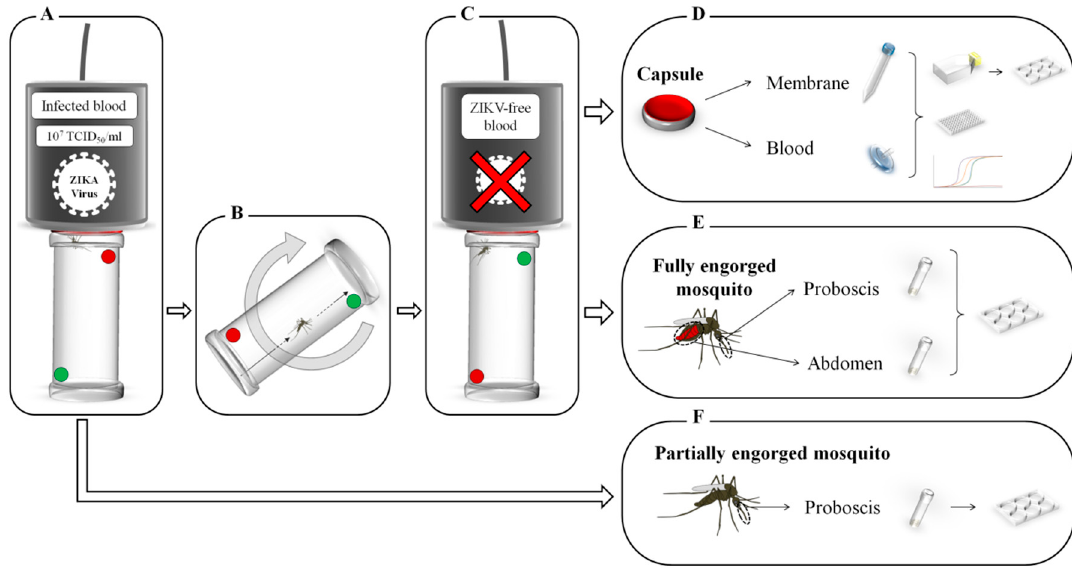
Figure 1. Experimental design used for the assessment of Zika virus (ZIKV) mechanical transmission by Aedes aegypti . ( A ) Mosquitoes were individualized in plastic tubes and allowed to start feeding on ZIKV-infected blood meal (called source capsule ) until blood was visually detected in their abdomen. ( B ) Once blood was detected, the tube was turned upside down and transferred to a virus-free blood meal (called receiver capsule ). ( C ) The mosquito was allowed to complete the blood meal for 30 min. ( D ) After engorgement, the receiver capsule compartments (feeding membrane and blood; N = 22) were screened for ZIKV by titration (virus culture, TCID 50 and plaque assays) and by real time RT-qPCR. ( E,F ) Fully engorged mosquito compartments (abdomens and proboscises; N = 22) as well as proboscises of partially engorged mosquitoes (only fed on the source capsule; N = 25) were investigated for the presence of ZIKV using plaque assay titration.